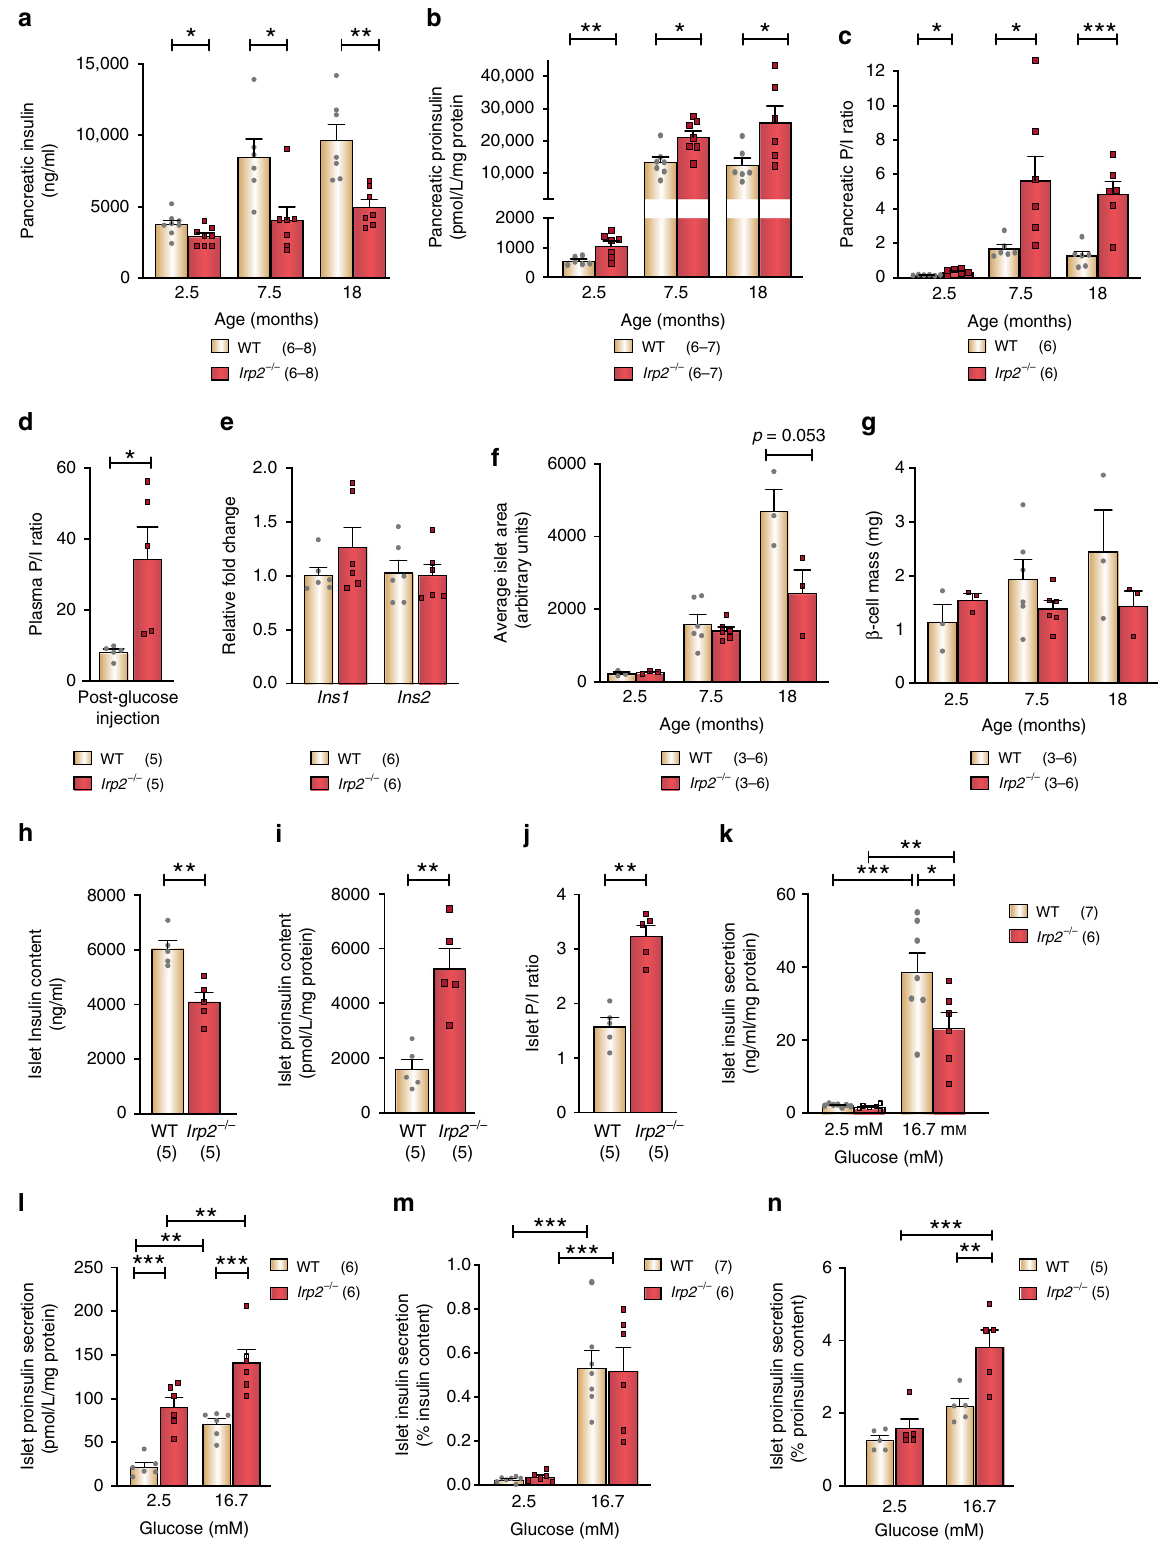
mice (Fig. 5h), suggesting that pancreatic iron overload may impair insulin production in normal mice. Collectively, these data indicate that maintenance of cellular iron homeostasis by Irp2 is critical for normal proinsulin processing and insulin